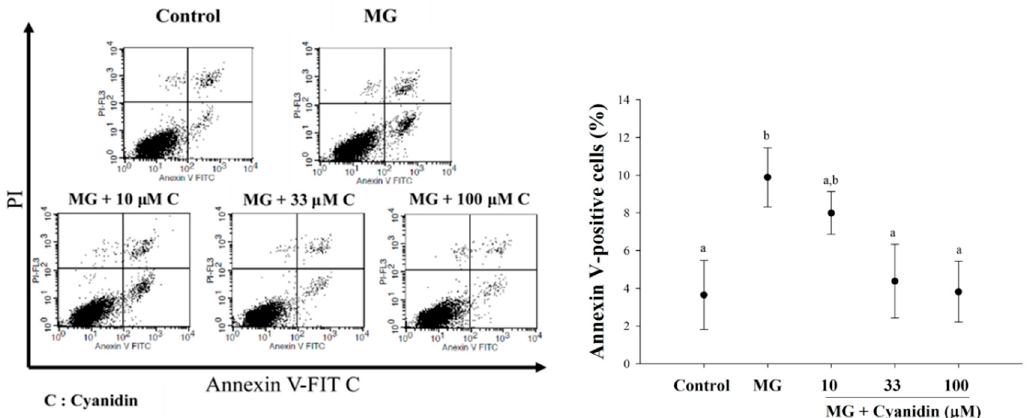
Figure 4. Effect of cotreatment of cyanidin and 500 µM methylglyoxal (MG) for 12 h on apoptosis. Cyanidin (33–100 µM) reduced MG-induced apoptosis in INS-1cells by the PI/Annexin V-FITC stain. Results are presented as mean ± SEM ( n = 3). The groups that do not share a common letter are significantly different ( p < 0.05).